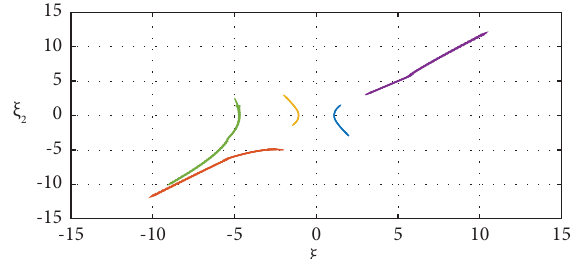
Figure 3: Behavior in the ξ